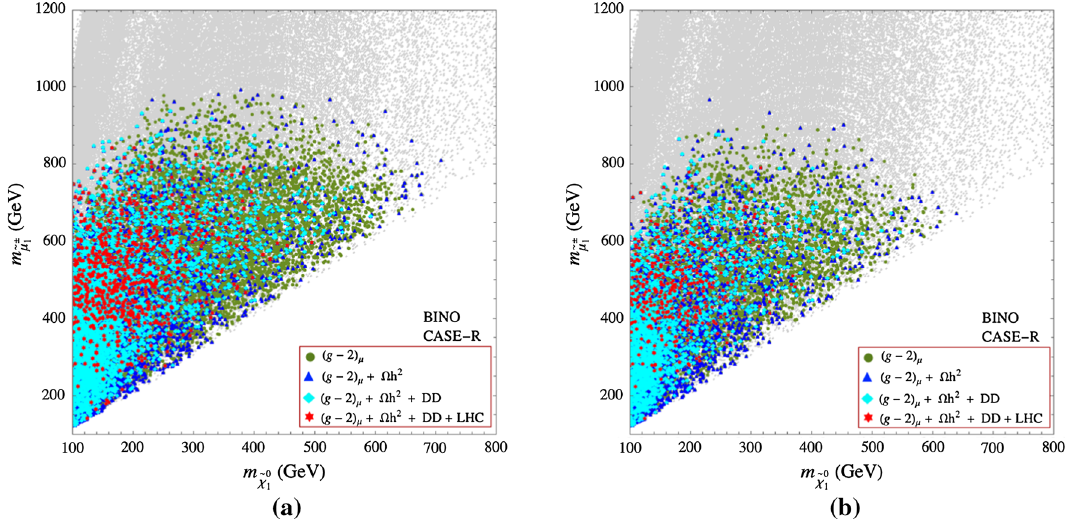
Fig. 19 The results of our parameter scan in the m ˜ χ 0 limits (right) from ( g − 2 ) μ . The color coding is as in Fig.